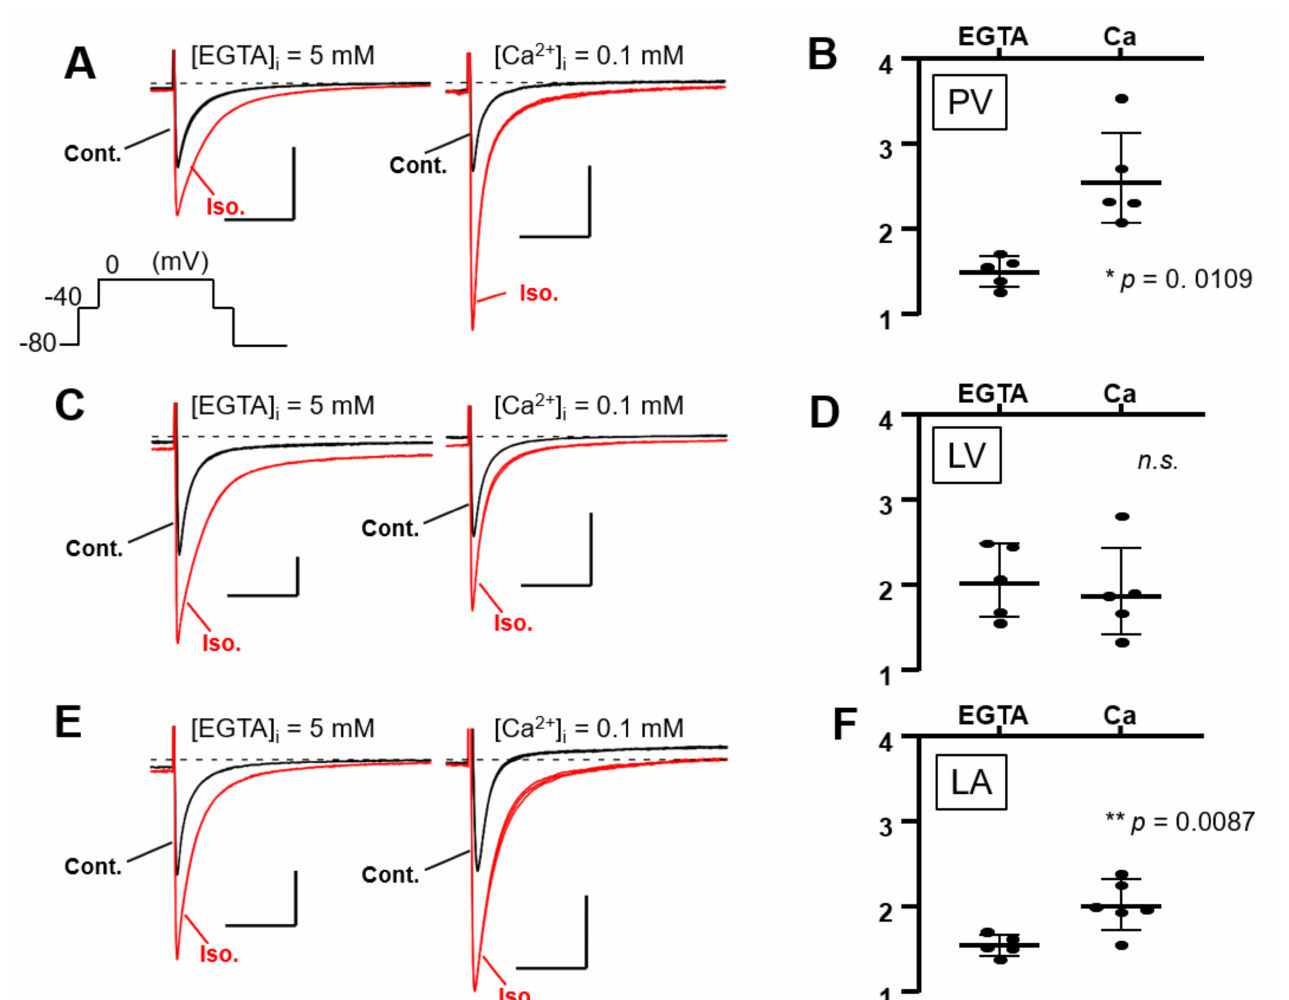
Figure 6. Ca 2+ -dependent effects of β -adrenergic stimulation on L-type Ca 2+ currents in three types of cardiomyocytes. As shown in the inset of ( A ), the Ca 2+ current is induced by a depolarizing pulse to 0 mV for 500 ms, followed by a depolarizing pulse to − 40 mV for 80 ms to inactivate the Na + current. The L-type Ca 2+ current is amplified by 1 µ M isoproterenol (Iso.), a β -adrenergic receptor-selective agonist. The strength of the β -adrenergic stimulation is evaluated by the rate of amplification of the current amplitudes. It was observed whether the absence or presence of intracellular Ca 2+ changed the strength of the β -adrenergic reaction. In Figure 8A,C,E, three stable sweeps are superimposed under control conditions (Cont., black) or Iso. conditions (red). Inserted time and current scales indicate 50 ms and 5 pA/pF, respectively. Dashed lines indicate zero current level. Intracellular Ca 2+ is chelated by 5 mM EGTA under the Ca 2+ -free condition, while the internal solution contains 0.1 mM Ca 2+ in the other. ( A ) Representative data from pulmonary vein (PV) cardiomyocytes. A statistical summary of an increase in calcium current by Iso. for each condition is shown in ( B ). ( C ) Representative data from left ventricular (LV) cardiomyocytes and summarized in ( D ). ( E ) Representative data from left atrial (LA) cardiomyocytes and summarized in ( F ). n.s. , not